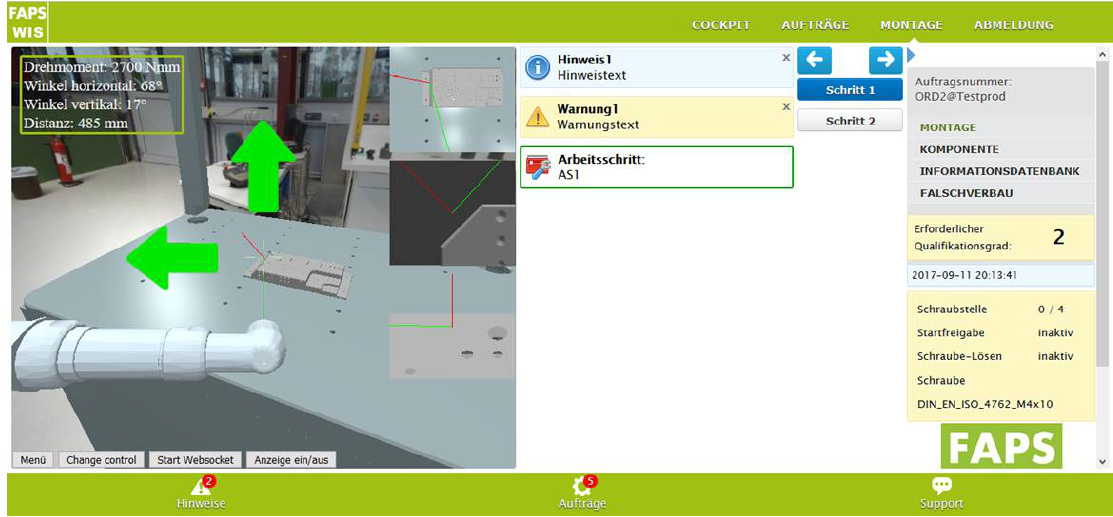
Figure 3. User Interface of the WIS with augmented reality visualization ( left ) and instructions ( right